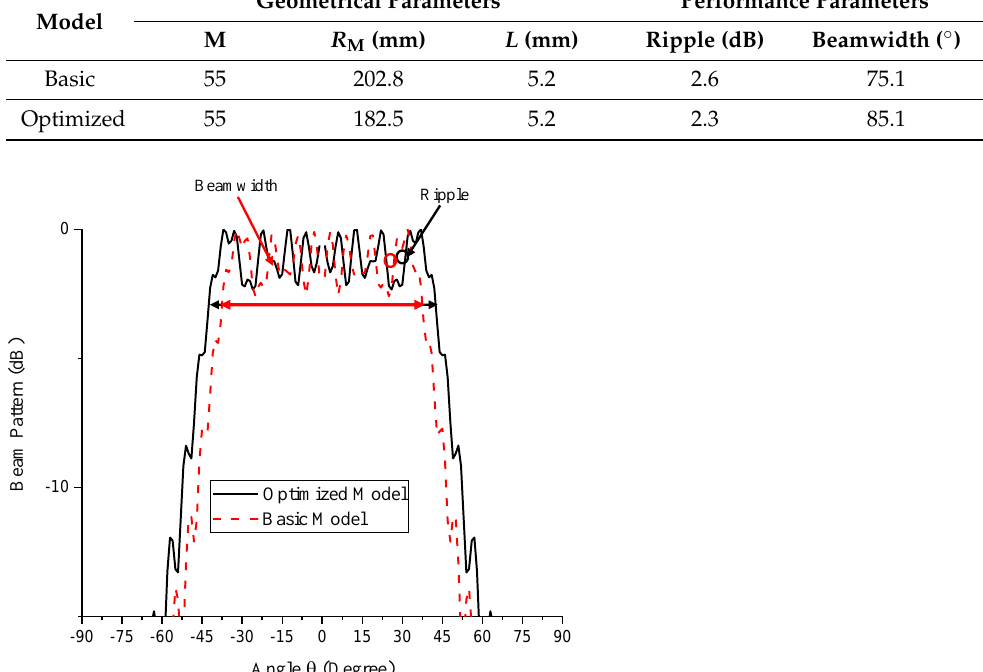
Figure 5. The beam pattern of the M-subarray part of the optimized conformal structure compared with the basic model.